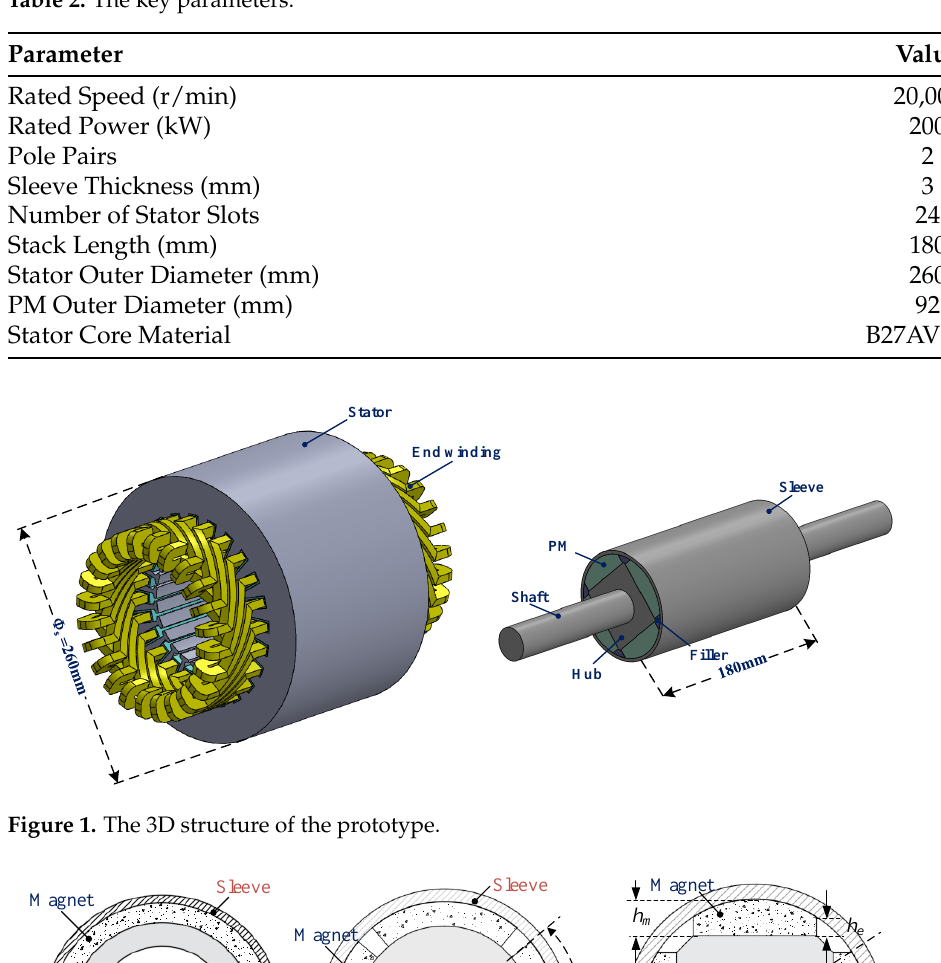
Table 2. The key parameters.